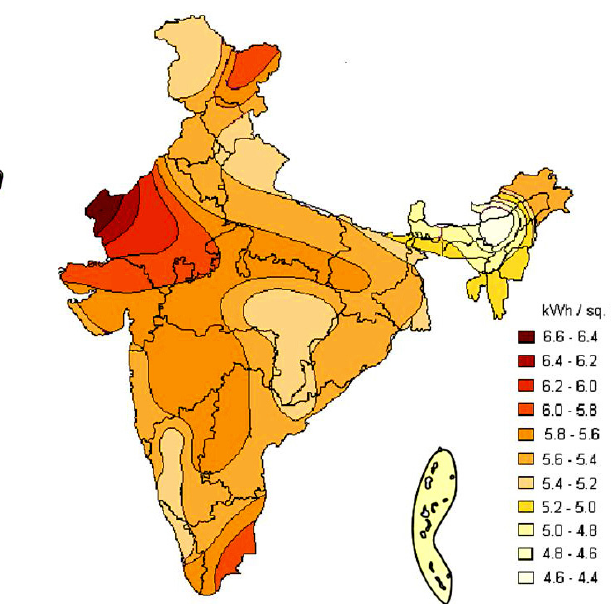
Figure. 4 Insolatiom map of India Average Daily Solar Radiation in units of kWh/m 2 .day Source: http://www.cercind.gov.in/ Lighter areas with insolation of 5.4 kWh/m 2 .day or less are the preferred habitat of Euthalia aconthea.